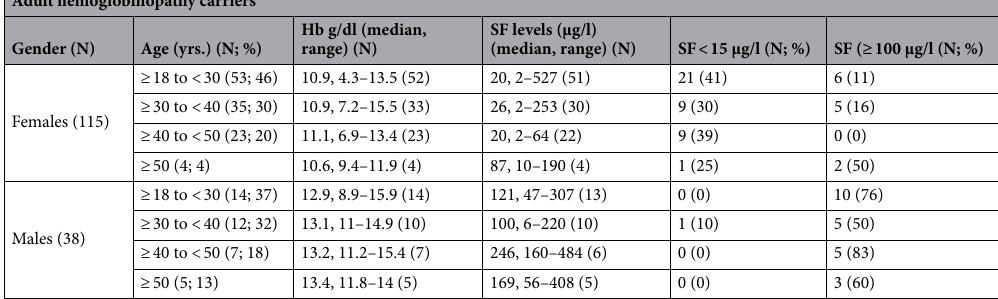
Adult hemoglobinopathy